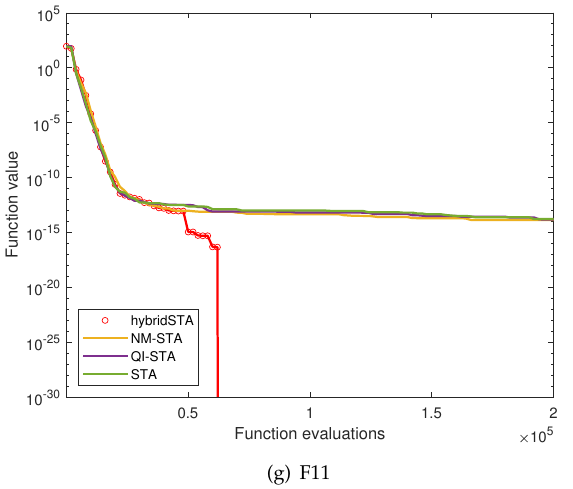
Figure 7. Average convergence curves of the STA family on benchmark functions with D = 30.